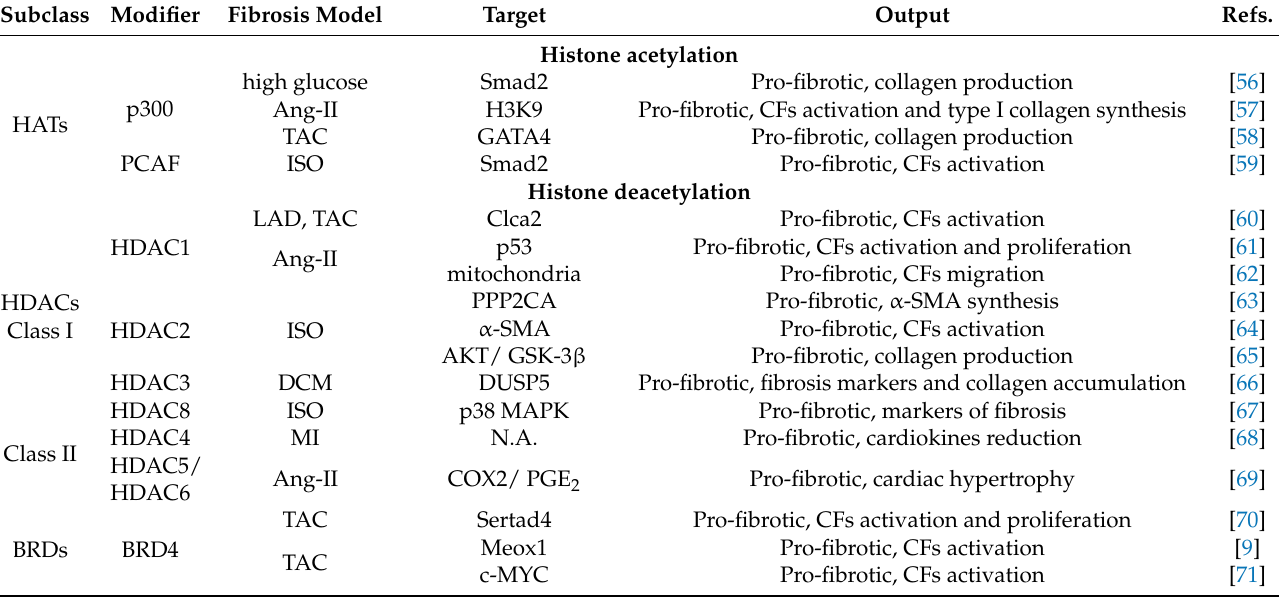
Table 2. The roles of histone acetylation modifiers in CFs activation and cardiac fibrosis. Target Output Refs. Histone